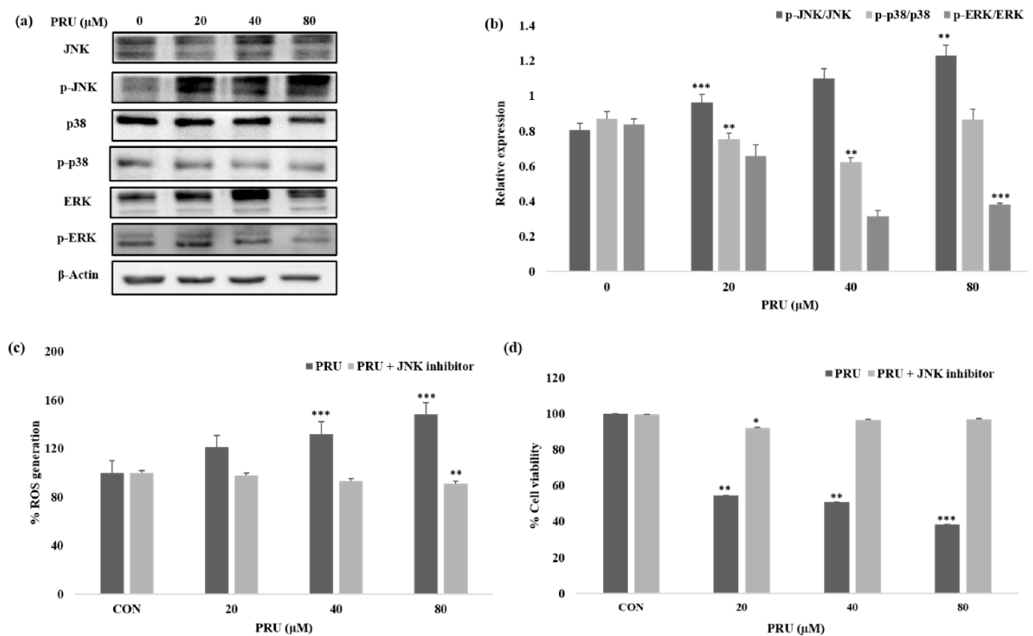
Figure 6. PRU induces cell death by ROS generation through JNK activation. ( a ) Western blot analysis of JNK, p-JNK, p38, p-p38, ERK, and p-ERK on PRU treated AGS cells. ( b ) The expression of phosphorylated proteins p-JNK, p-p38, and p-ERK are represented graphically based on their densitometry. ( c ) The e ff ect of ROS generation was measured by fluorescent intensity detection in AGS cells with and without co-treatment with specific JNK inhibitor SP100125 (10 µ M). ( d ) Cell viability assay performed on PRU treated AGS cells with and without co-treatment with JNK inhibitor SP100125 (10 µ M). Values are given as the mean ± standard error of the mean (SEM). * p < 0.05 vs. control, ** p < 0.01 vs. control, *** p < 0.001 vs. control.